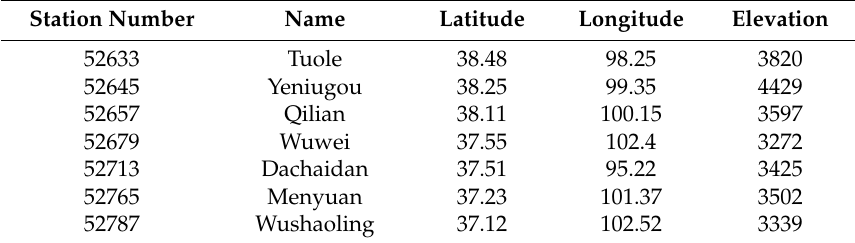
Table 1. The location of seven meteorological stations in the Qilian